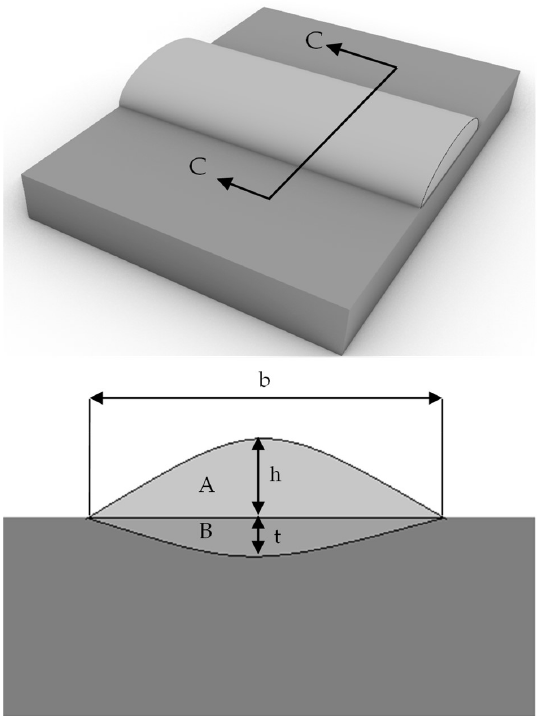
Figure 3. Schematic illustration of C-C cross-section of the weld seam.